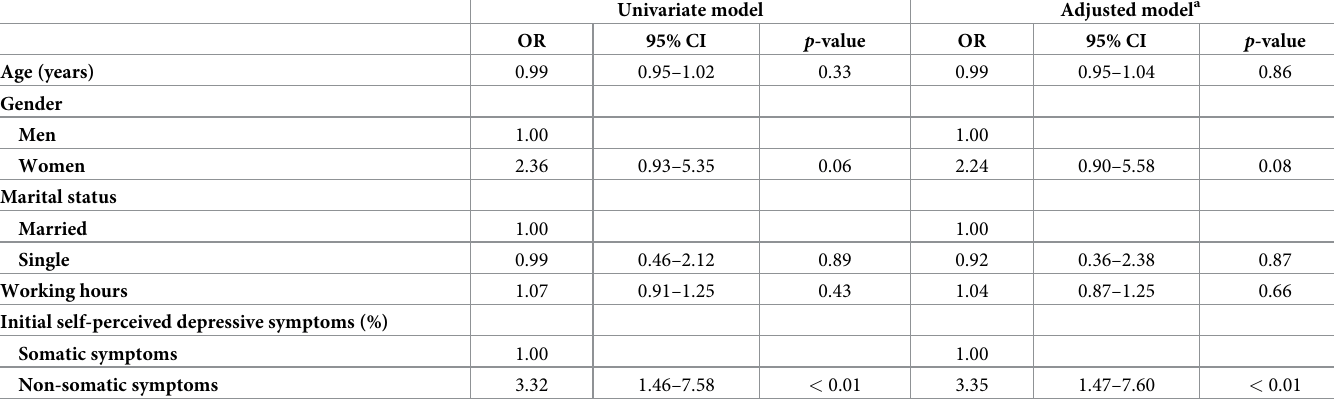
Table 3. Logistic regression analyses of MDD severity, depressive symptoms, and